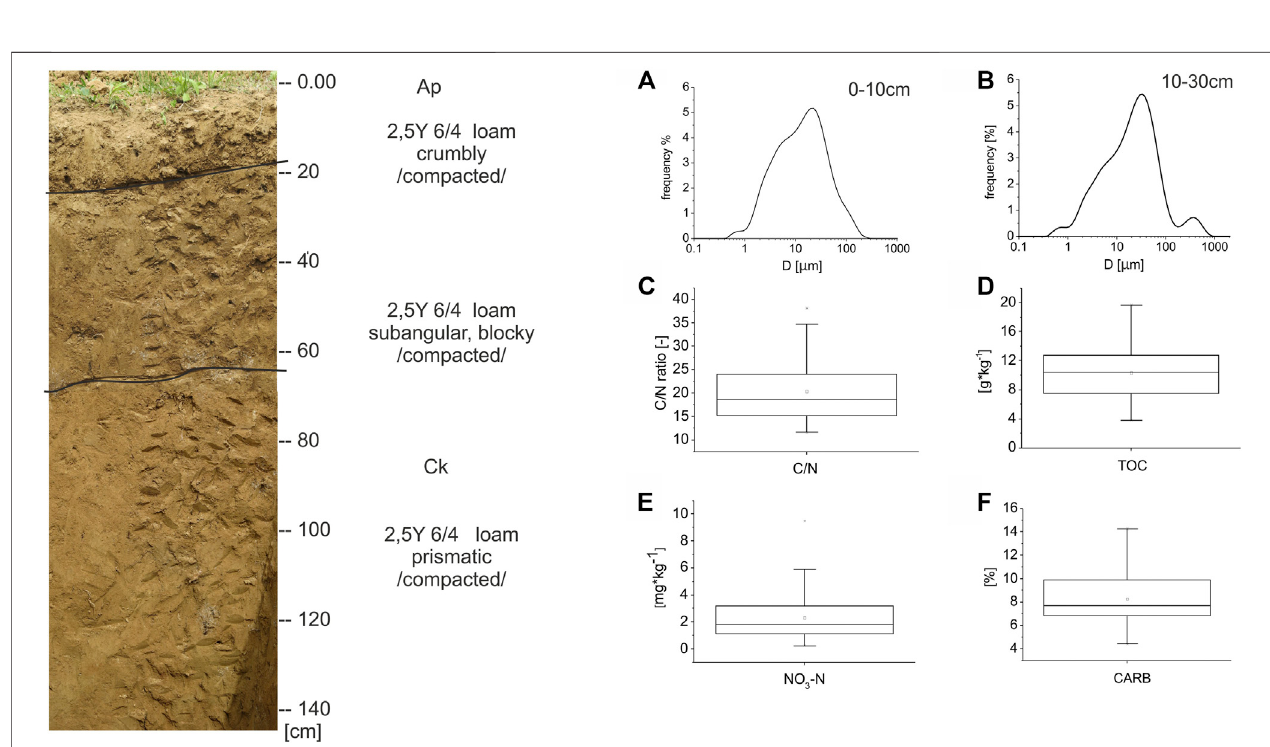
FIGURE 4 | Villány, general soil pro fi le and main important properties of the soil (data from last experimental year (2020) (A) . characteristic PSD distribution of 0 – 10 cm and (B) 10 – 30 cm layer; (C) :, C/N ratio; d: TOC ( g kg − 1 ); (E) : NO 3 - N ( mg kg − 1 ); (F) : carbonate content (%).